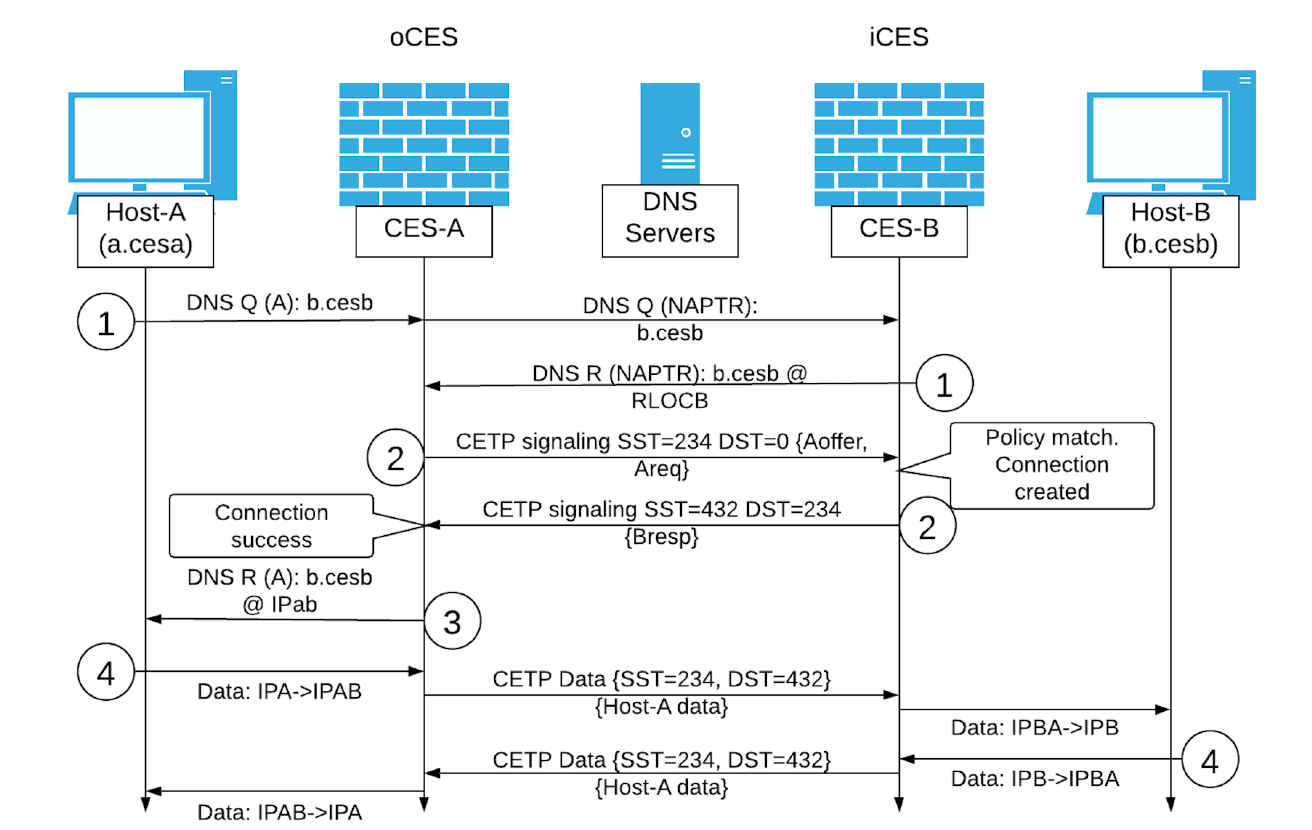
Figure 5. CETP signaling–scenario with CES-to-CES communication